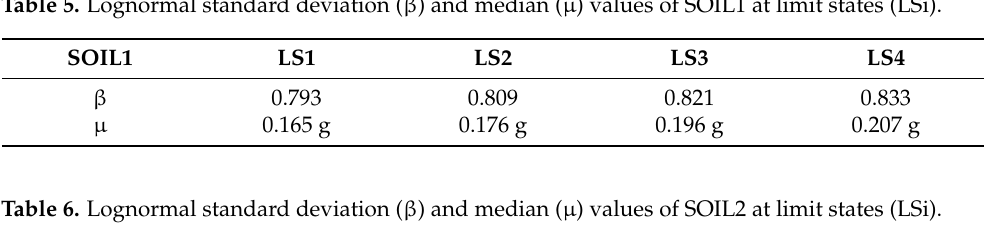
Table 6. Lognormal standard deviation ( β ) and median ( µ ) values of SOIL2 at limit states (LSi). SOIL2